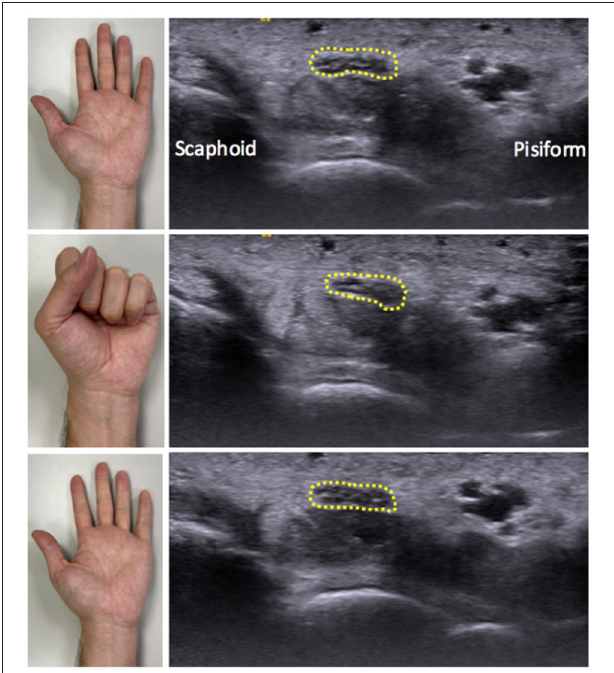
FIGURE 1 | Illustration of wrist positioning during dynamic ultrasound scanning and the correspondingly ultrasound images. The participants were instructed to fully flex their hand from the initial neutral extension and then return to the beginning posture. The ultrasound probe was placed at the level of the carpal tunnel inlet, allowing the median nerve (dotted round) to be